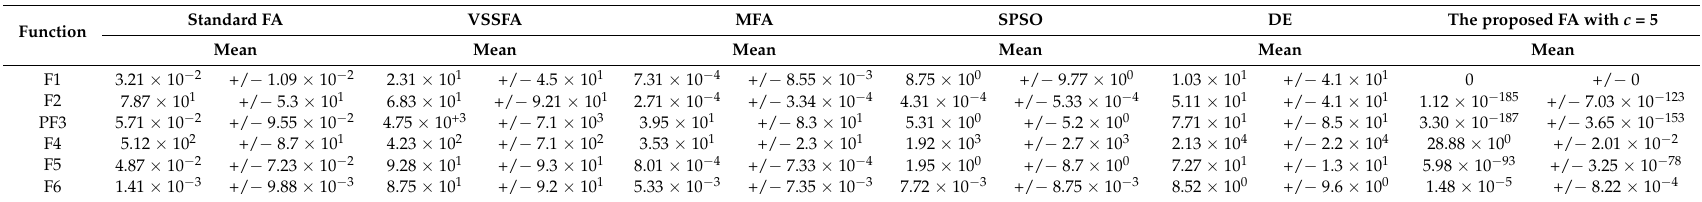
Table 4. Results obtained by the standard FA, Variable Step Size Firefly Algorithm (VSSFA), Memetic Firefly Algorithm MFA, particle swarm optimization (PSO), differential evolution (DE), and the proposed FA on the test suite.